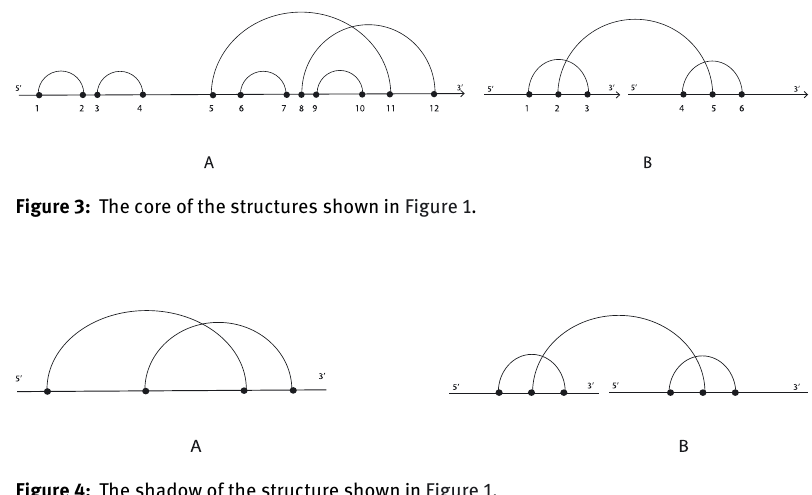
Figure 4: The shadow of the structure shown in Figure